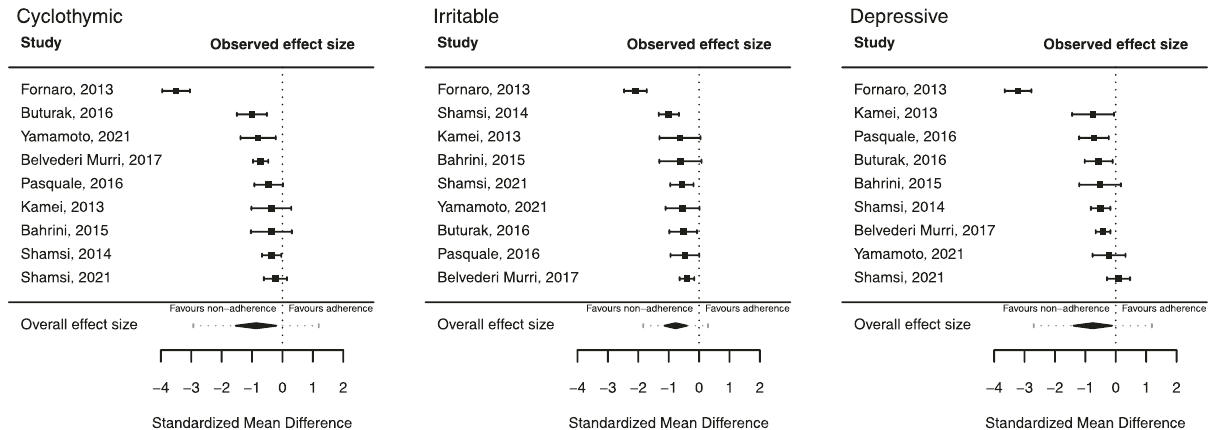
Fig. 2 Meta-analysis of studies investigating the effect of affective temperaments on medication adherence. Forest plots based on random- effects meta-analyses of TEMPS-A scores for cyclothymic, irritable, and depressive temperaments with 95% con fi dence intervals (CIs) in nine comparisons of adherent versus non-adherent subjects (total n = 1138), with pooled standardized mean differences (SMDs). The estimated 95% prediction interval (PI) likewise presented, in which the true effect size was predicted to fall in 95% of all comparable